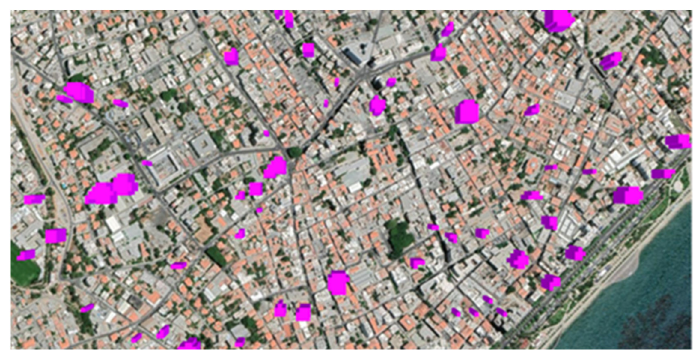
Figure 15. Focused analysis of the study areas by means of change detection maps of ( a ) Strovolos; ( b ) the Turkish-Cypriot quarter of Limassol. Figure 16. 3D change detection map of Limassol.